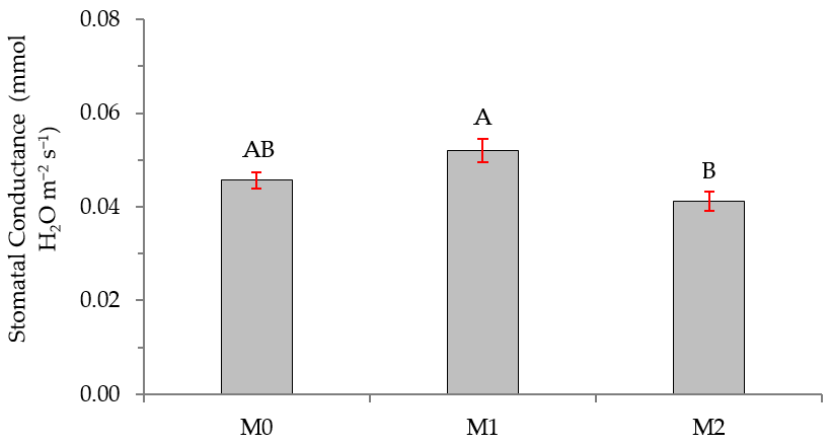
Figure 8. Stomatal conductance in Nothofagus alessandrii plants as a function of MFI treatment (M0, M1, and M2). Di ff erent le tt ers represent signi fi cant di ff erences at p < 0.05.